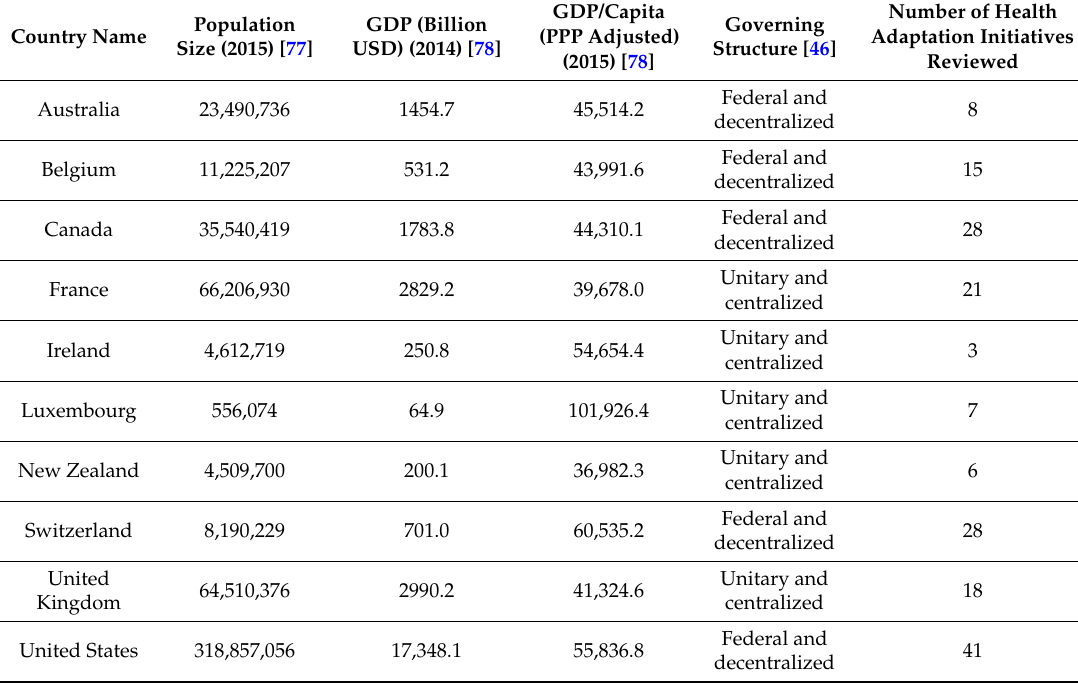
Table 2. Country